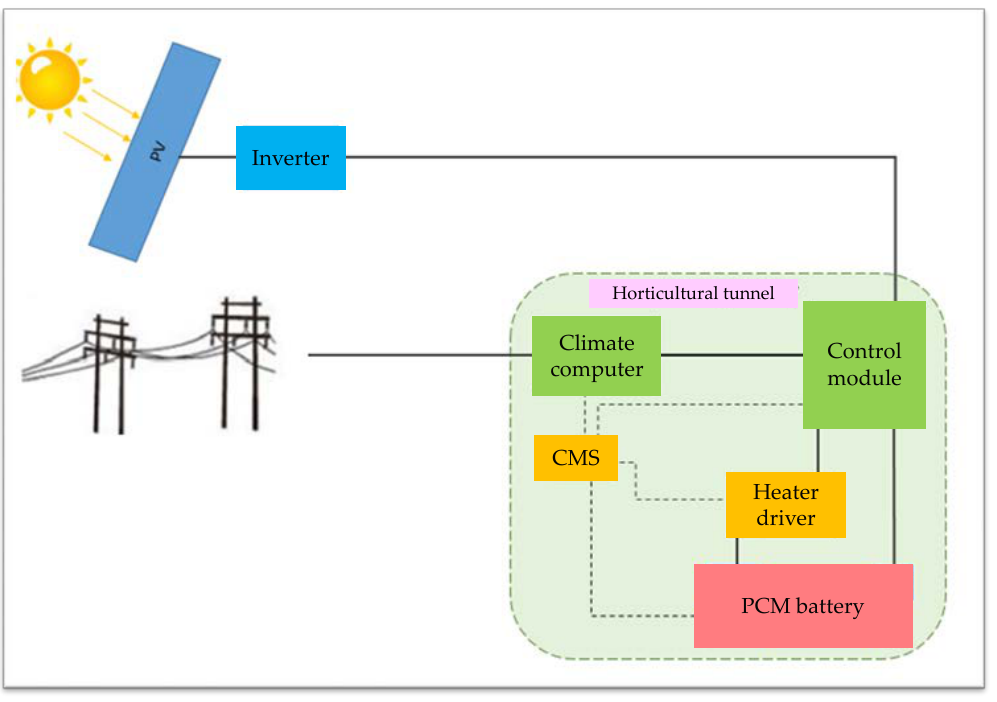
Figure 2. PCM battery powering system.